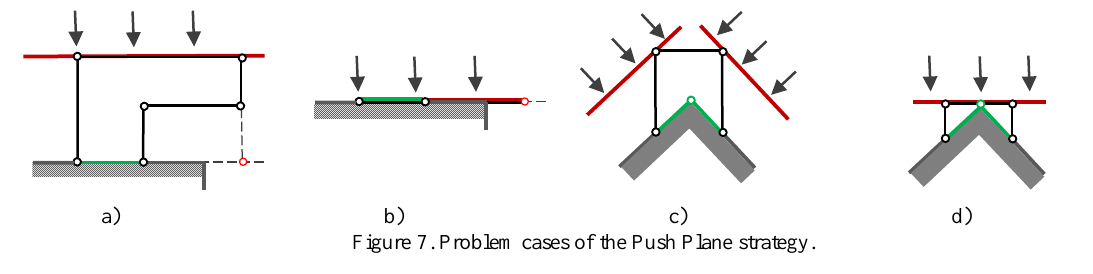
Figure 7. Problem cases of the Push Plane